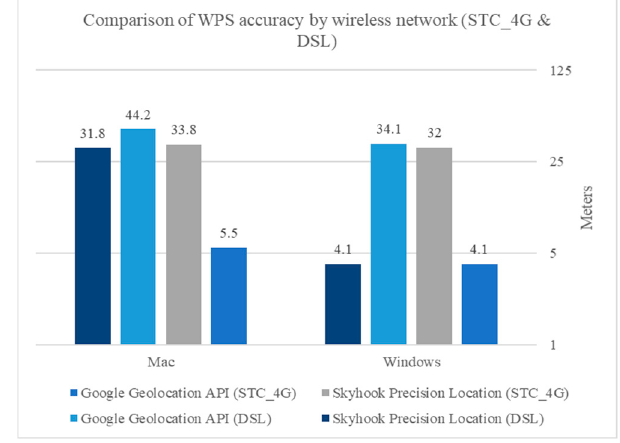
Figure 7. Comparison analysis of the WPS.